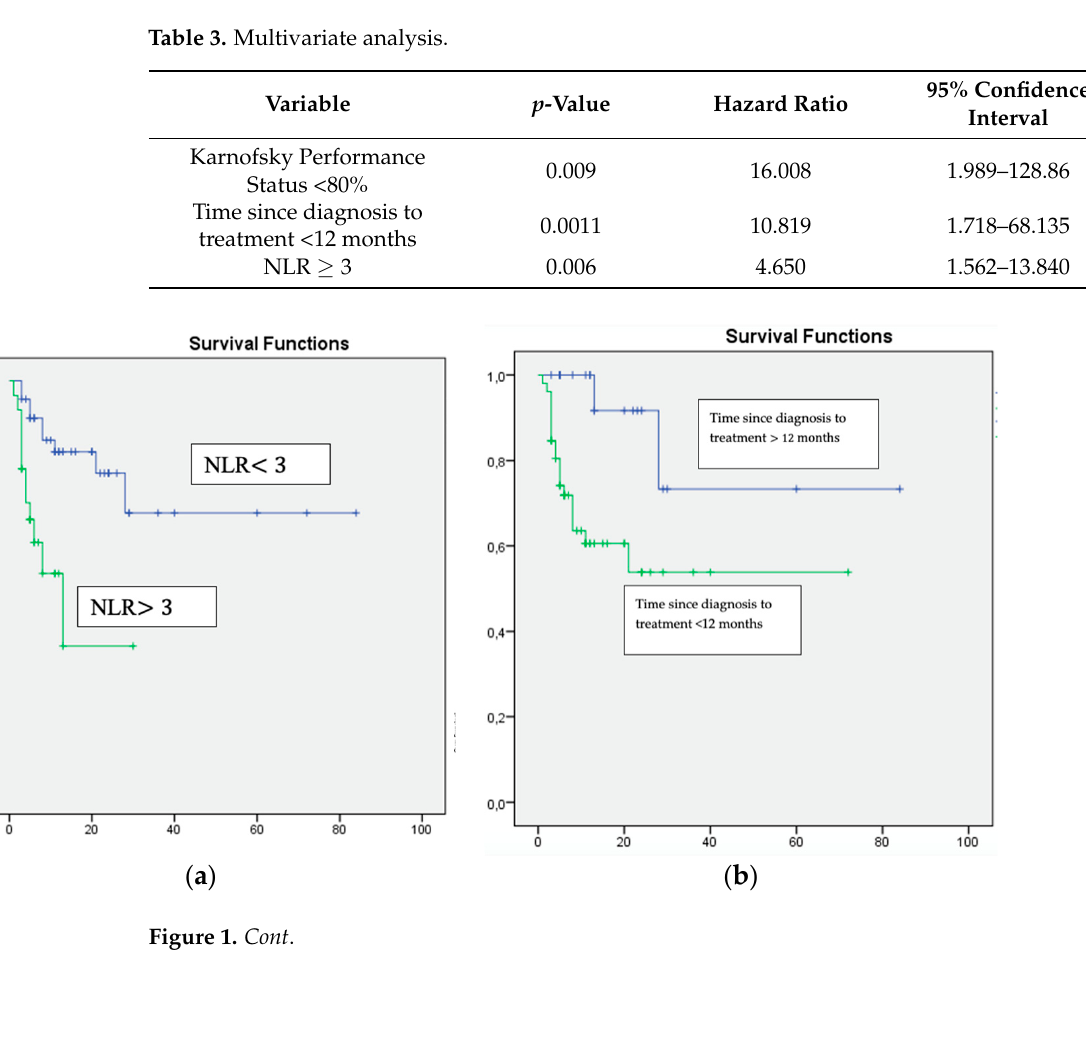
Table 3. Multivariate